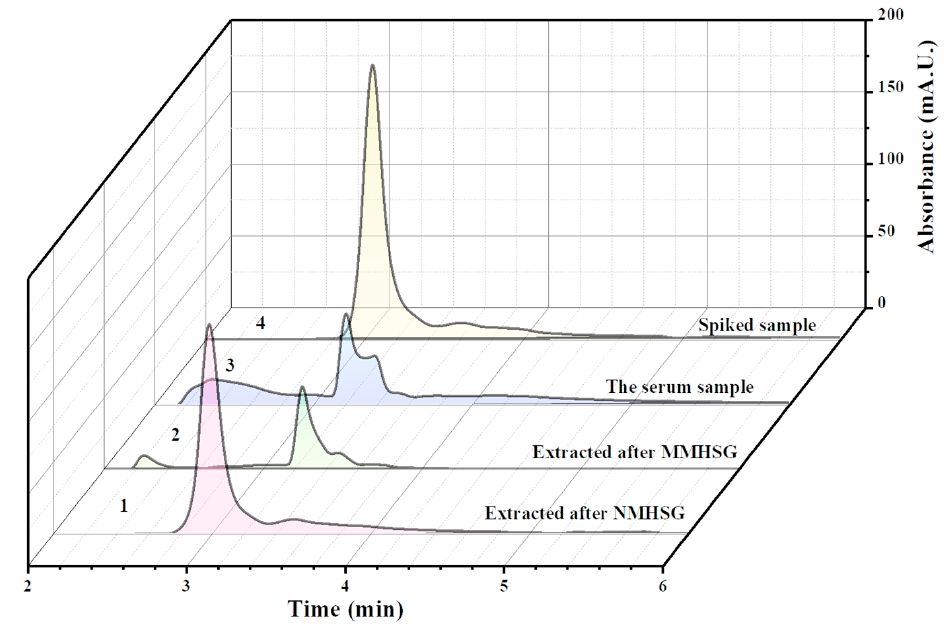
Figure 11. HPLC chromatogram analysis of dA-spiked human serum samples.